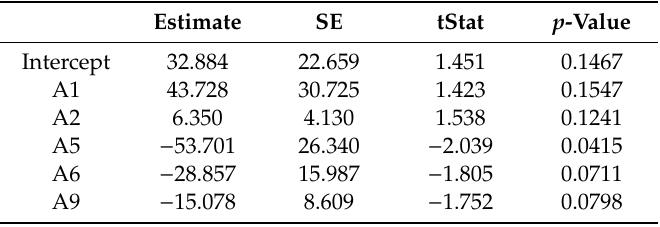
Table 2. The derived GLM from nine calculated canopy metrics for individual